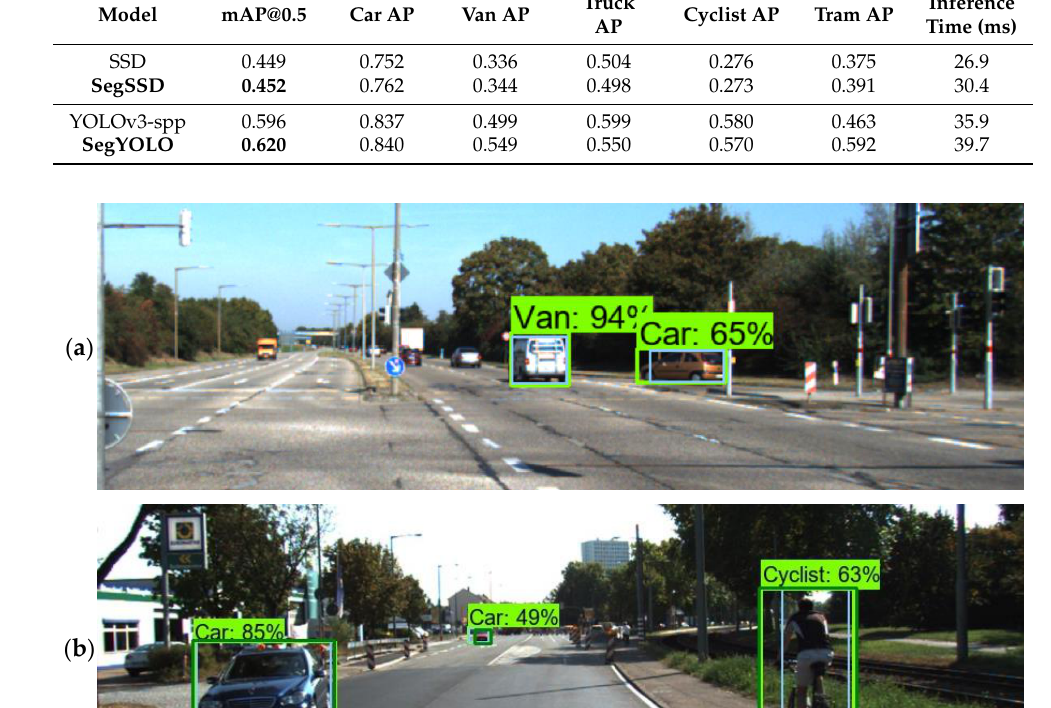
Table 2. KITTI test detection results. Inference times are test on GTX1650 GPU.